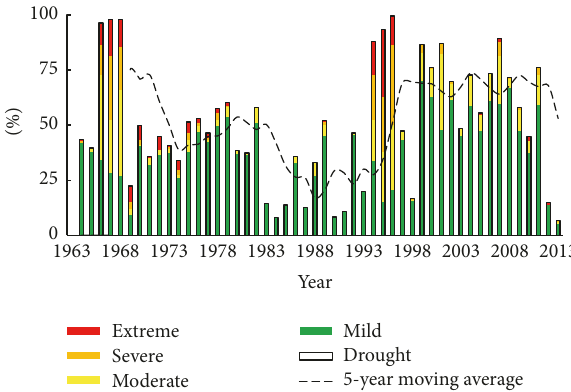
Figure 4: The interannual variability of drought area.